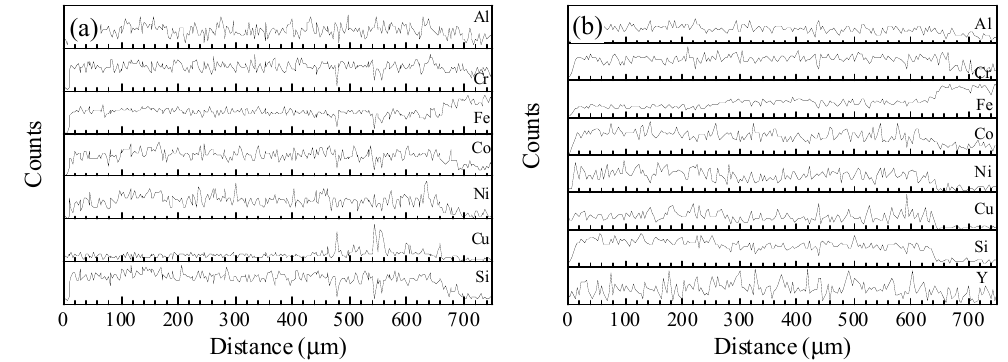
Figure 3. Quantitative EDS line analysis over the thickness of the laser cladding HEA coatings without and with Y 2 O 3 as indicated by line 1 and 2 in Figure 2a and Figure 2d, respectively. ( a ) Without Y 2 O 3 ; ( b ) with Y 2 O 3 .